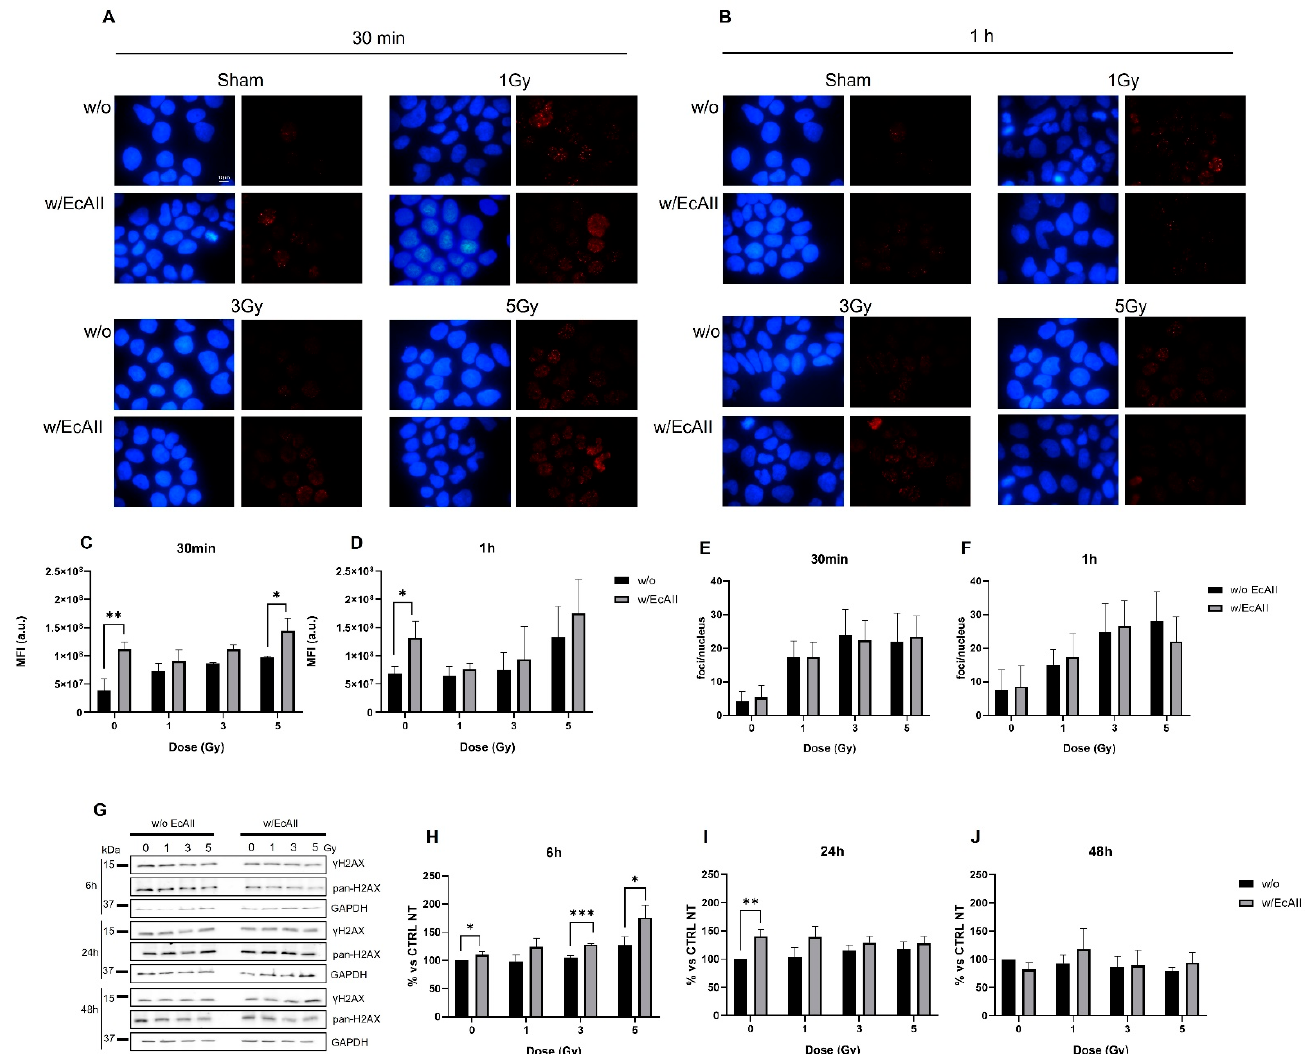
Figure 3. ɣ H2AX analysis for Caco-2 cells exposed to different doses of X rays (0, 1, 3 and 5 Gy), without (w/o) or with 1 U/mL EcAII (w/EcAII). Panels ( A , B ), illustrative fluorescence microscopy images for the different irradiation and treatment conditions obtained with Hoechst (blue for nuclear DNA, left) and ɣ H2AX (red for DNA damage foci, right) of the sample fixed 30 min and 1 h after irradiation, respectively. Images were acquired using a 100X magnification. Cells pre-treated with EcAII for 72 h before radiation exposure. Panels ( C , D ), mean fluorescence intensity (MFI) per cell of the ɣ H2AX signal (a.u.). ( E , F ) The count of H2AX foci/nucleus was obtained using open software ImageJ v 1.53 for the sample harvested 30 min and 1 h after irradiation, respectively. ( G ) Cells treated with EcAII after radiation exposure. Illustrative Western blot images of ɣ H2AX (S139) and pan-H2AX. The densitometric analysis was performed by evaluating the p-H2AX/total H2AX ratio with changes expressed relative to the unirradiated and untreated control at each time point (% vs. CTRL NT). Samples in the absence of EcAII and with EcAII were harvested at 6 h ( H ), 24 h ( I ) and 48 h after irradiation ( J ). Data reported are mean ± SD, obtained from at least three independent experiments. Statistical significance (Student’s t -test) was calculated comparing the w/o and w/EcAII conditions for each dose and time point (Student’s t -test) and is as follows: * p < 0.05, ** p < 0.01, *** p < 0.001. In all charts black bars represent samples w/o EcAII and gray bars represent samples w/EcAII.